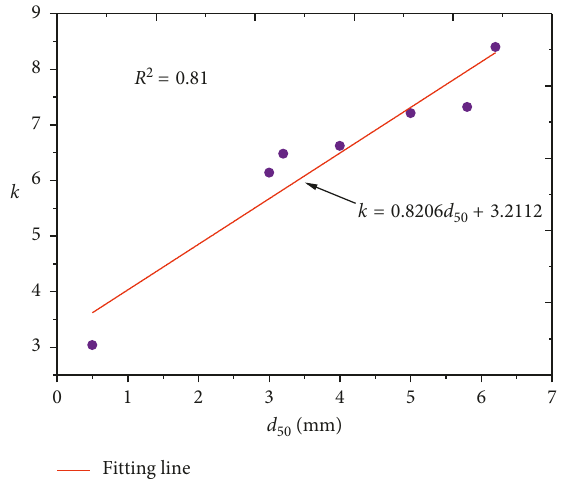
Fitting line Figure 13: The relationship between parameter k and medium diameters. The data are from Jiang et al.